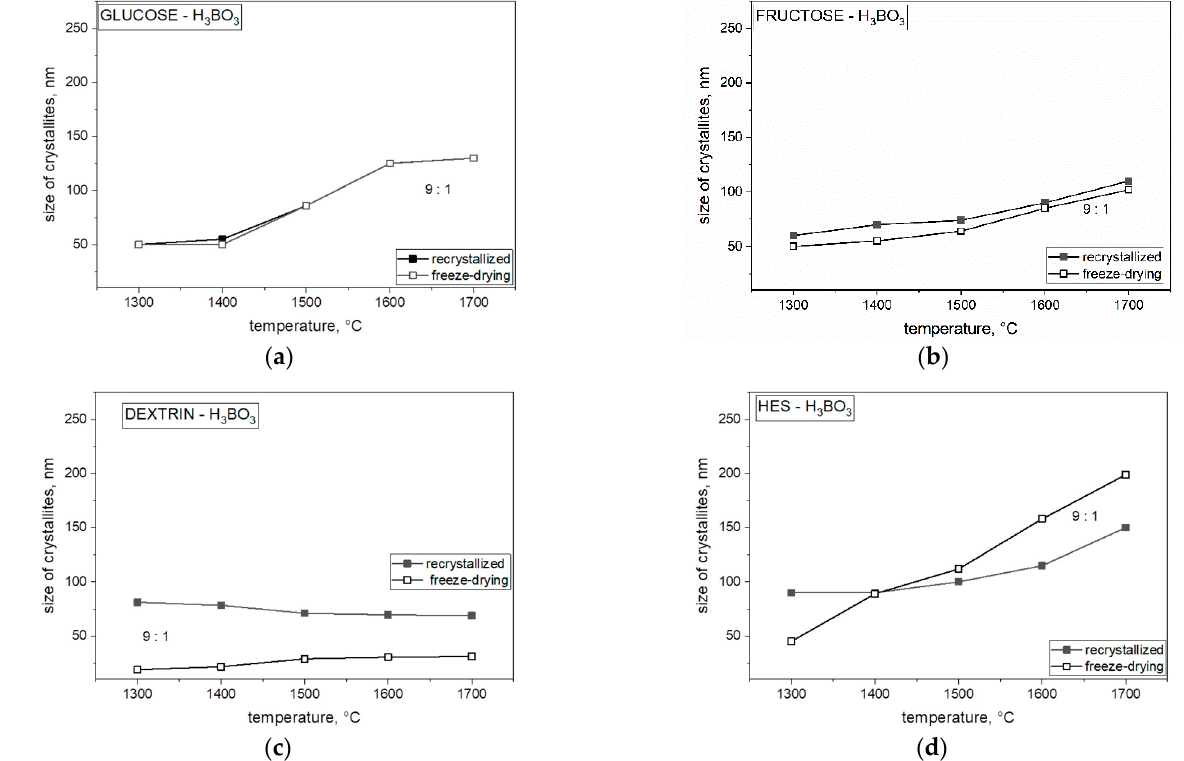
Figure 9. The changes in the crystallize size of boron carbide obtained with different precursors mixed with boric acid with a molar ratio of 9 C:1 B using both methods and heat treatment from 1300 to 1700 °C: ( a ) glucose, ( b ) fructose, ( c ) dextrin, and ( d ) HES.